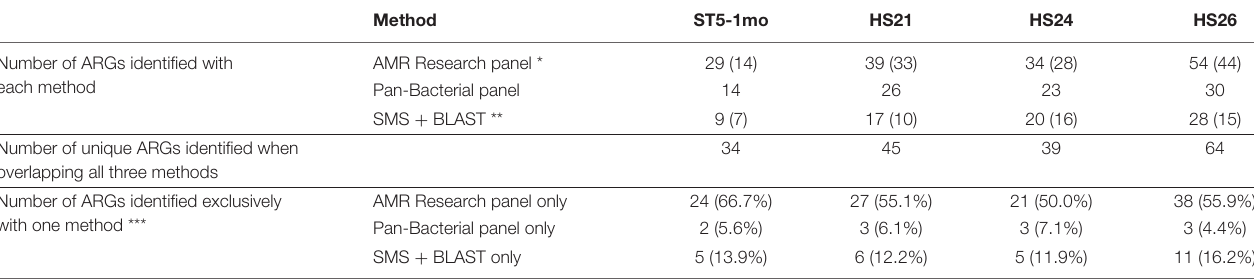
TABLE 3 | Number of antimicrobial resistance genes (ARGs) identified with three sequencing methods from four human samples.